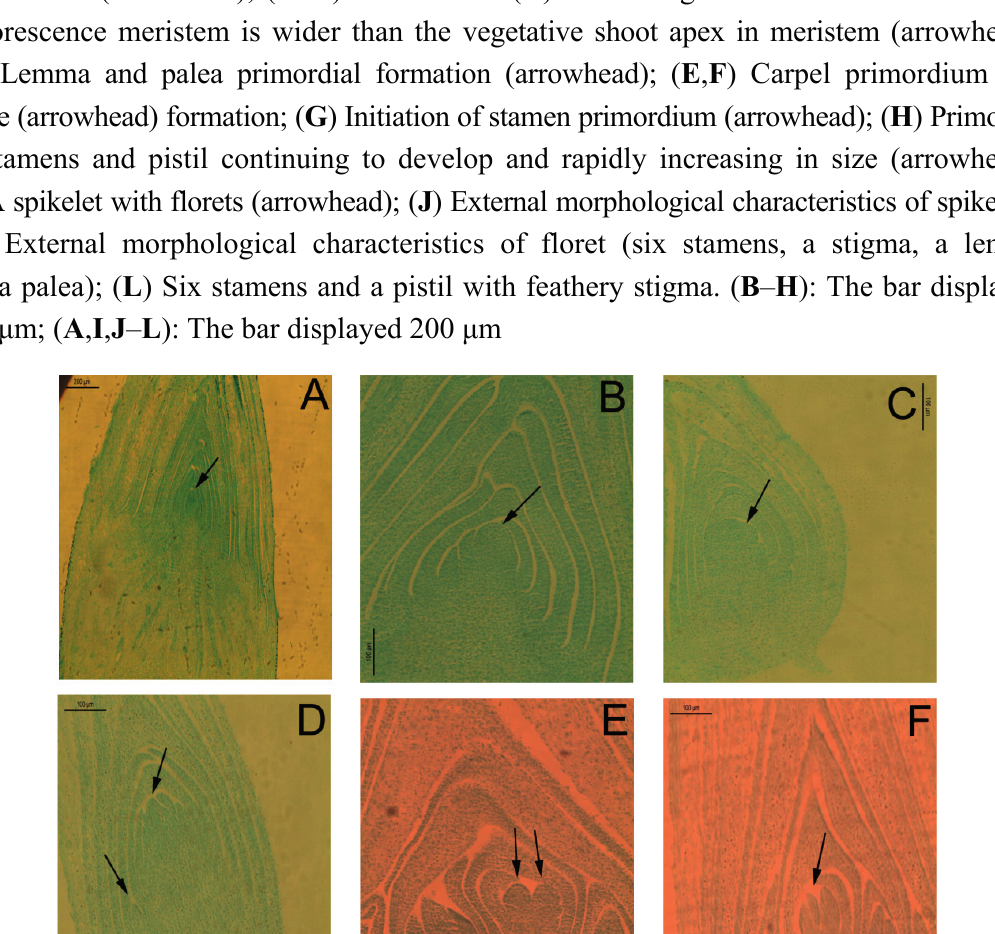
Figure 1. Morphogenesis of vegetative buds and floral buds of Dendrocalamus latiflorus according to the paraffin section inspection: ( A , B ) Vegetative buds; vegetative shoot apex in meristem (arrowhead); ( C – L ) Floral buds. ( C ) Initial stage of inflorescence meristem. Inflorescence meristem is wider than the vegetative shoot apex in meristem (arrowhead); ( D ) Lemma and palea primordial formation (arrowhead); ( E , F ) Carpel primordium and ovule (arrowhead) formation; ( G ) Initiation of stamen primordium (arrowhead); ( H ) Primordia of stamens and pistil continuing to develop and rapidly increasing in size